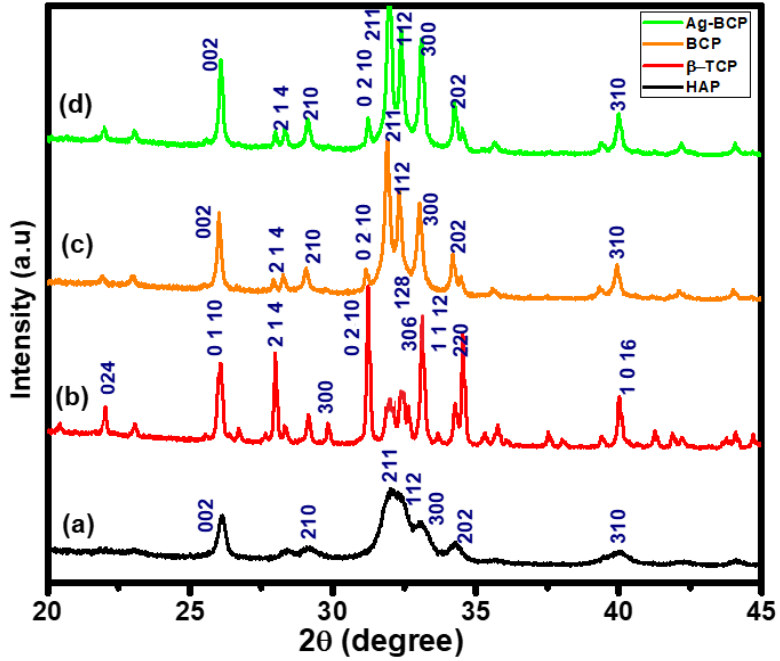
Figure 3. Powder XRD analysis for ( a ) HAP, ( b ) β -TCP, ( c ) BCP, and ( d ) Ag-BCP. 309